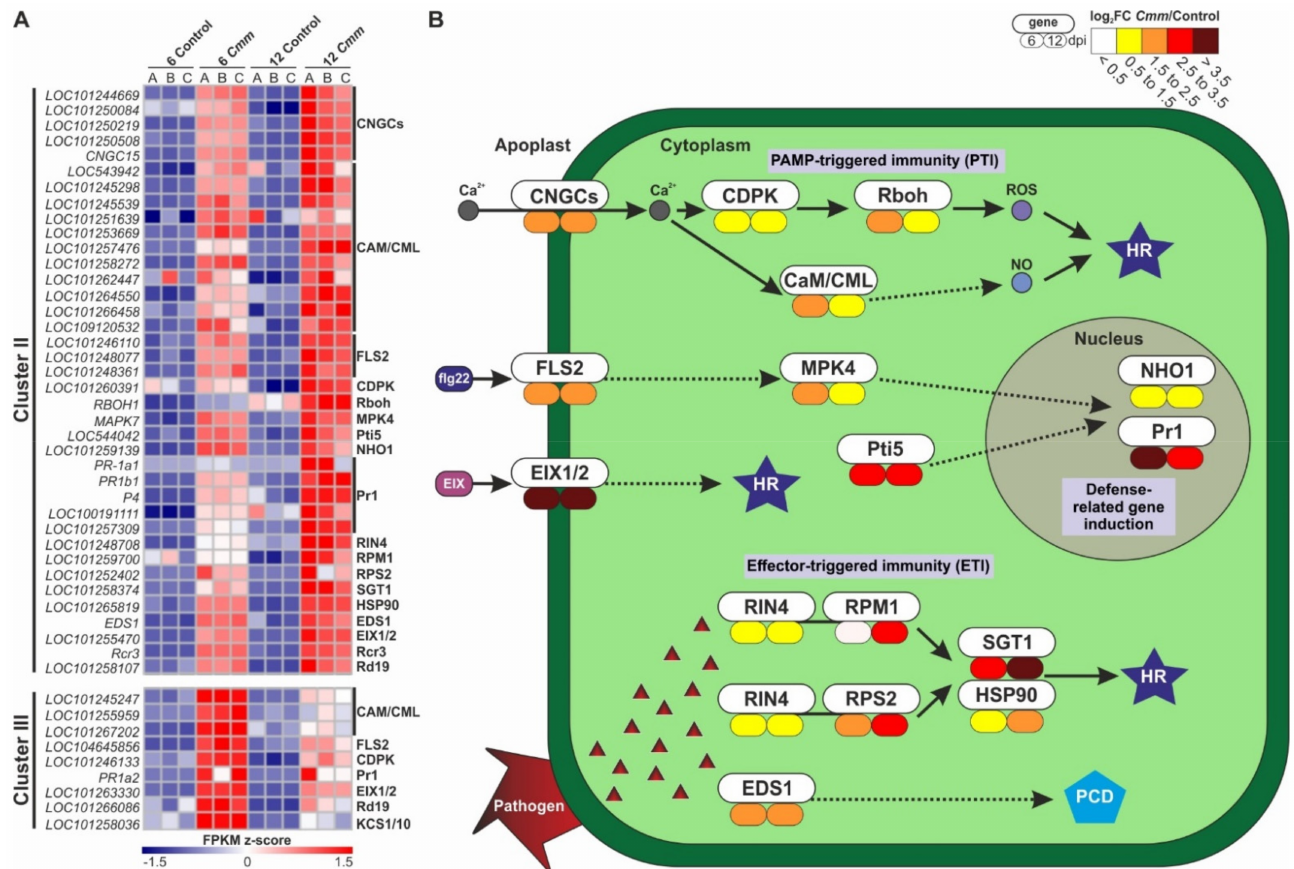
Figure 6. Host genes of the plant-pathogen interaction pathway activated by Cmm . ( A ) Heat map visualizing the stimulated expression pattern of genes involved in the plant-pathogen interaction pathway of Clusters II and III. ( B ) Graphical presentation of the expression fold change ( Cmm /control) of genes controlling plant defense-immunity pathways at 6 and 12 dpi. HR: hypersensitive response; PCD: programmed cell